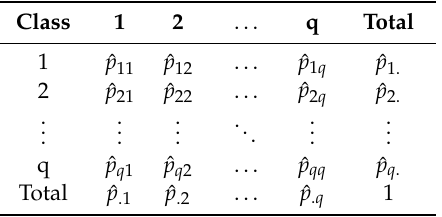
Table 3. Example of error matrix of estimated area proportions, ˆ p ij